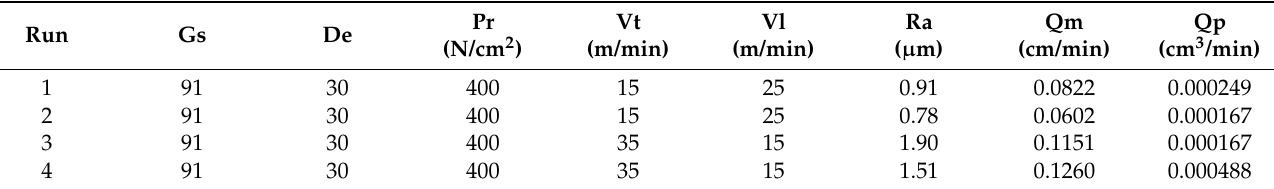
Table A1. Experimentation results in the rough